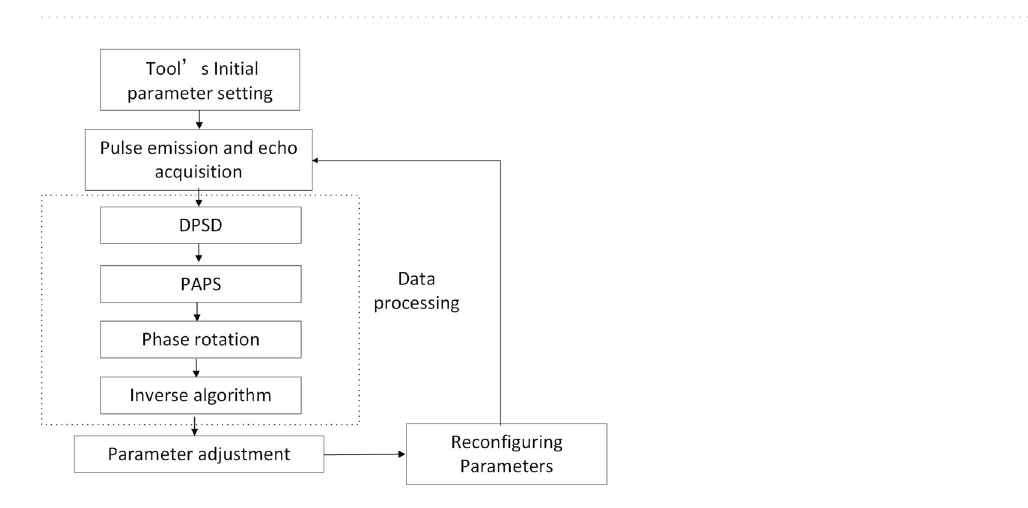
Figure 7. Schematic diagram of the FPGA for adaptive adjustment of the pulse